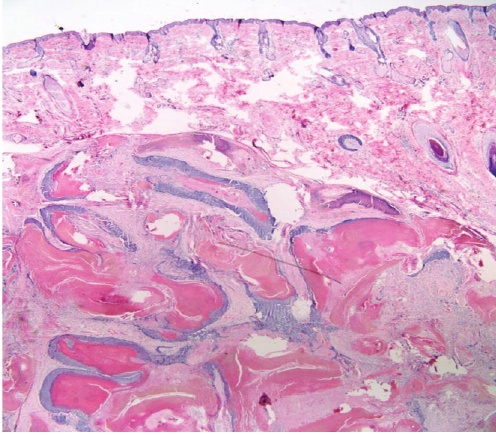
Figure 5: Low magnification H&E stained histopathological slide showing islands of epithelial cells with areas of